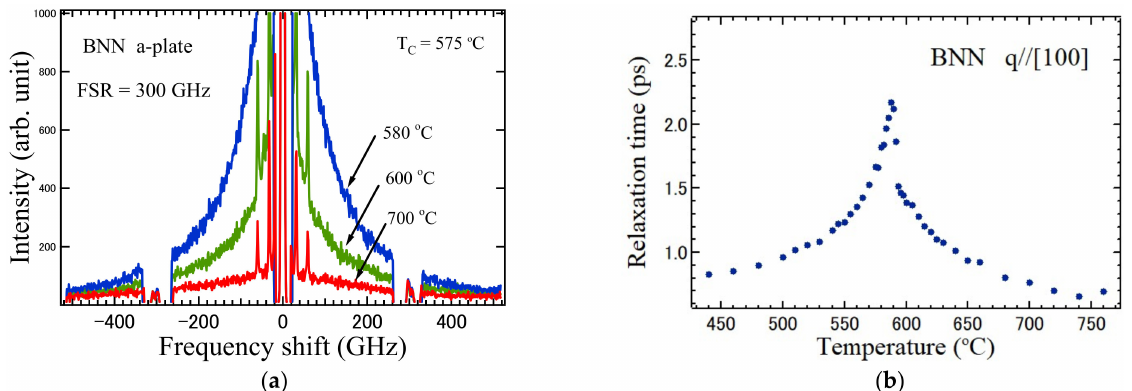
Figure 8. ( a ) Broadband Brillouin scattering spectra observed at backward scattering in a para- electric phase of BNN [61]. A broad central peak appears in the vicinity of the Curie temperature. ( b ) Temperature dependence of relaxation time determined by the width of a broad central